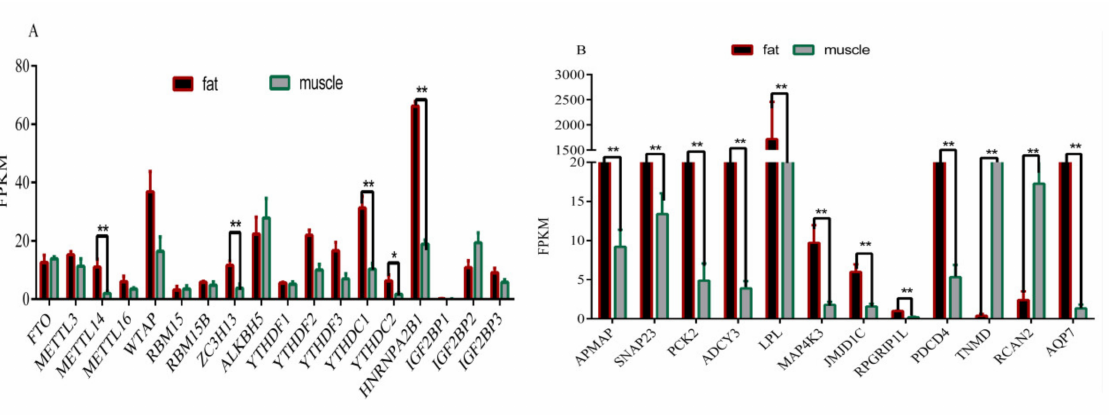
Figure 4. Overview of differentially expressed of methylase genes and key genes in muscle and adipose tissue samples. ( A ) FPKM of the methylase genes in muscle and adipose tissues; ( B ) FPKM of the key genes in muscle and adipose tissues (“*”, p ≤ 0.05; “**”, p ≤